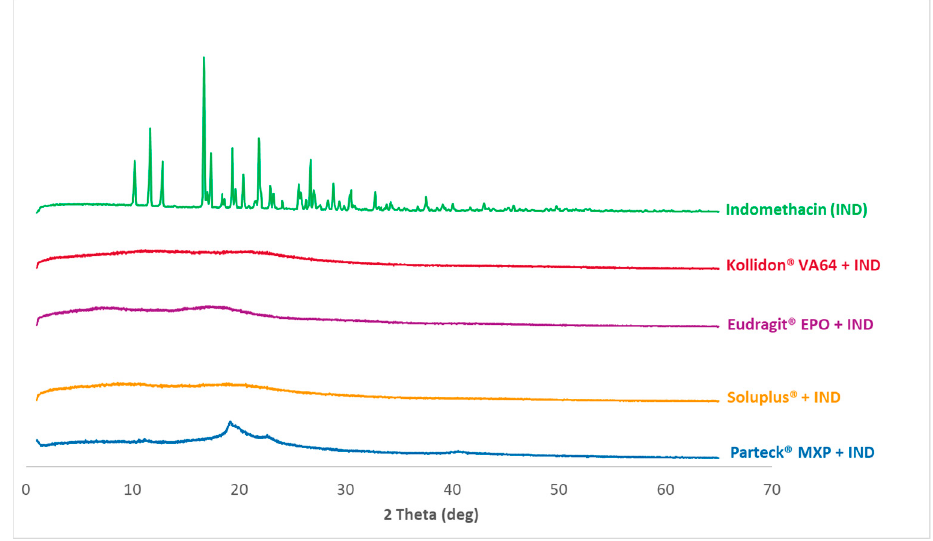
Figure 6. PXRD measurements: Diffractograms for processed HME samples and pure indomethacin diffractogram for reference purpose is given in the back as a single curve.